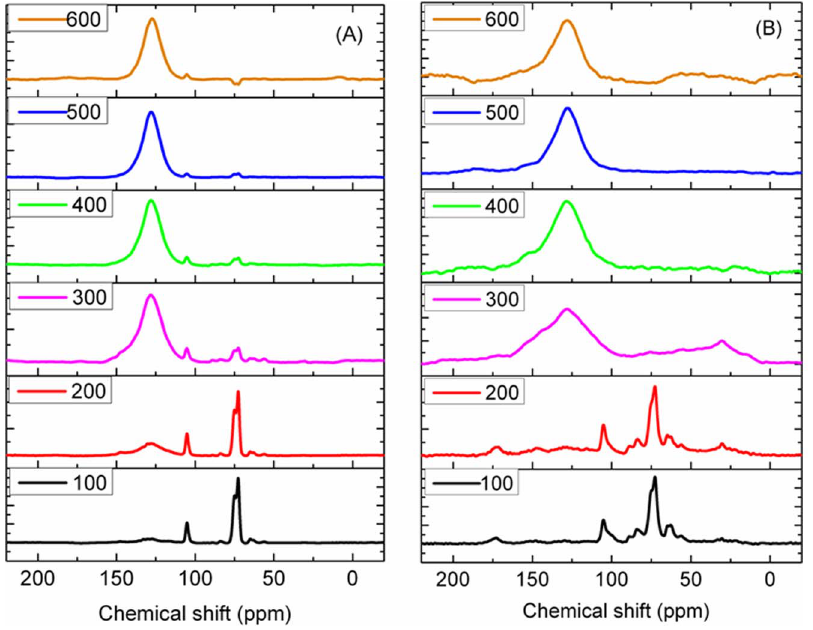
Figure 2. Solid-state 13 C NMR spectra of rice straw (A) and rice bran (B) derived biochars prepared at various charring temperatures.